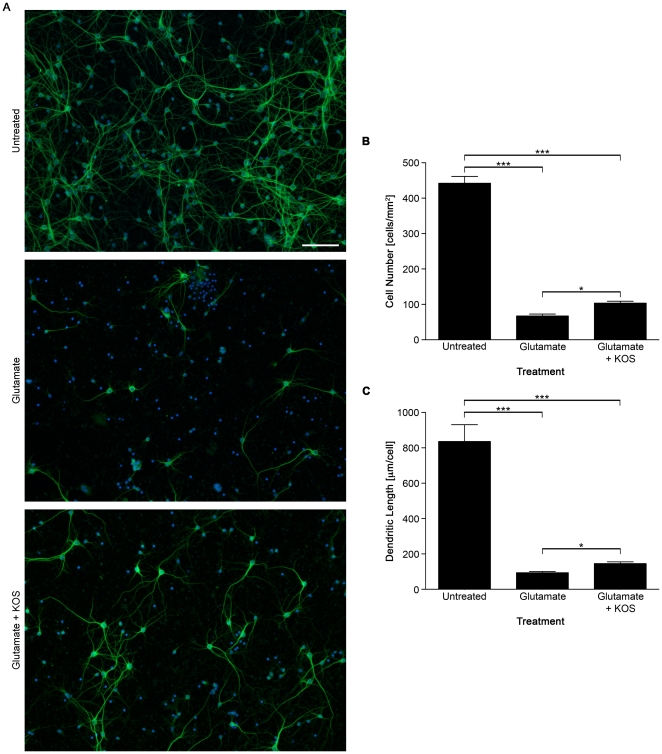
Koshu GSE augments cell survival of cultured hippocampal neurons after excitotoxic treatment.Hippocampal neurons plated at 2.0×105 cells/cm2 were treated with 50 µM glutamate in the presence or absence of 1.0 ng/ml KOS GSE for 10 min and allowed to recover in conditioned medium for 24 hr. (A) Representative images of hippocampal neurons after treatment. Bar, 100 µm. (B) The mean density of MAP2-positive neurons surviving 24 hr after glutamate treatment (n = 8). ***, P<0.001; *, P<0.05. (C) Quantification of the mean dendrite length by morphometric analysis (n = 8). ***, P<0.001; *, P<0.05.